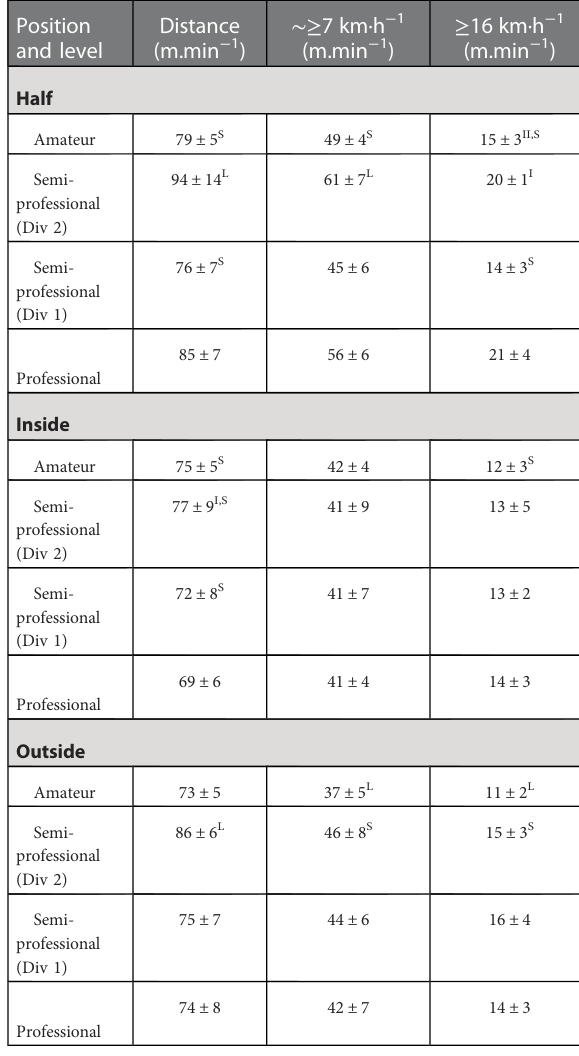
TABLE 3 Relative distance measures (mean±SD) for forward positions in all levels of rugby competition. Position and level